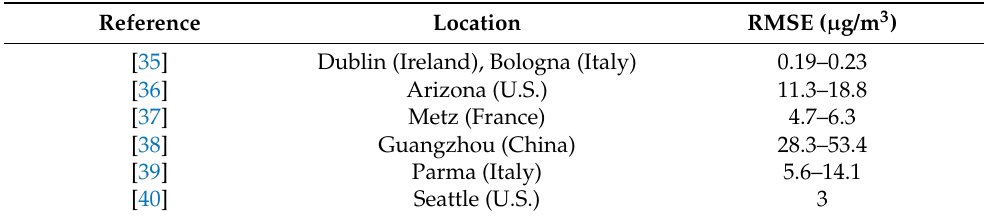
Table 10. Results from other studies evaluating NO 2 sensors (B43F series) calibrated with reference instrumentation.